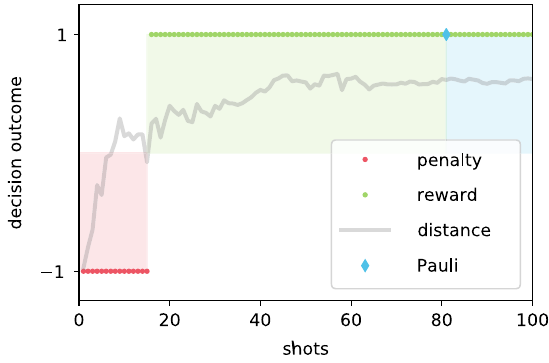
FIG. 10. Decision game. A quiz master constructs a quantum game where she provides us experimenters, having access to a quantum computer, with a circuit to prepare a state and